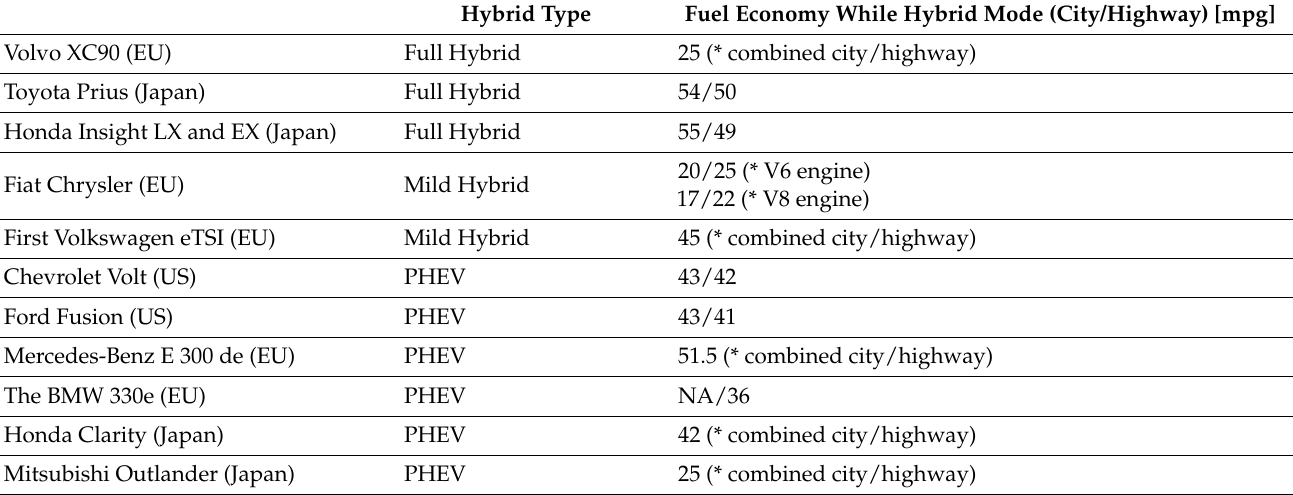
Table 5. The main characteristics of various